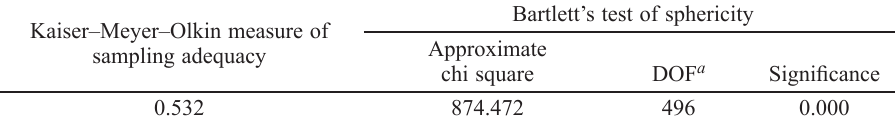
Table 4. KMO and Bartlett’s test of path analysis